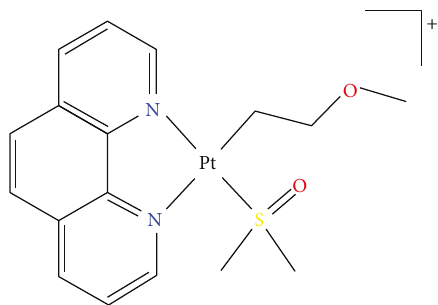
Figure 1: Chemical structure of the novel [Pt( ƞ 1 -C (DMSO)(phen)] + organometallic Pt(II) complex, Pt-EtOMeSO